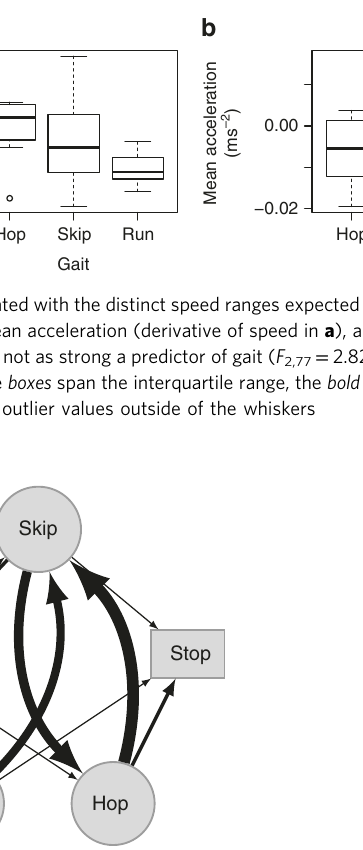
Fig. 2 Path diagram of observed transitions between gaits, starting, and stopping for 36 trials. The path thickness represents the frequency of transitioning from one gait to another. The camera fi eld of view included the center of the track, not the ends, resulting in a bias towards capturing more stopping, rather than starting, events